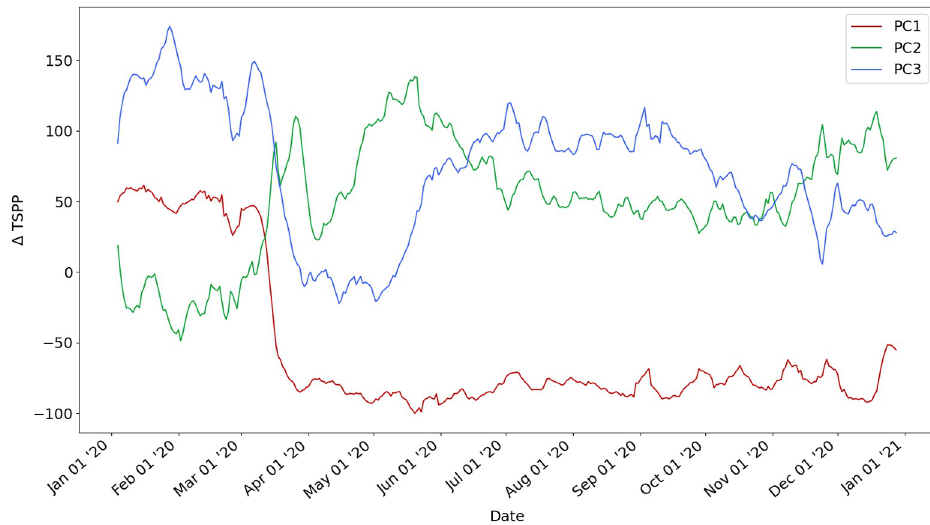
Fig 4. Three latent features describing mobility in the US mapped back into the temporal